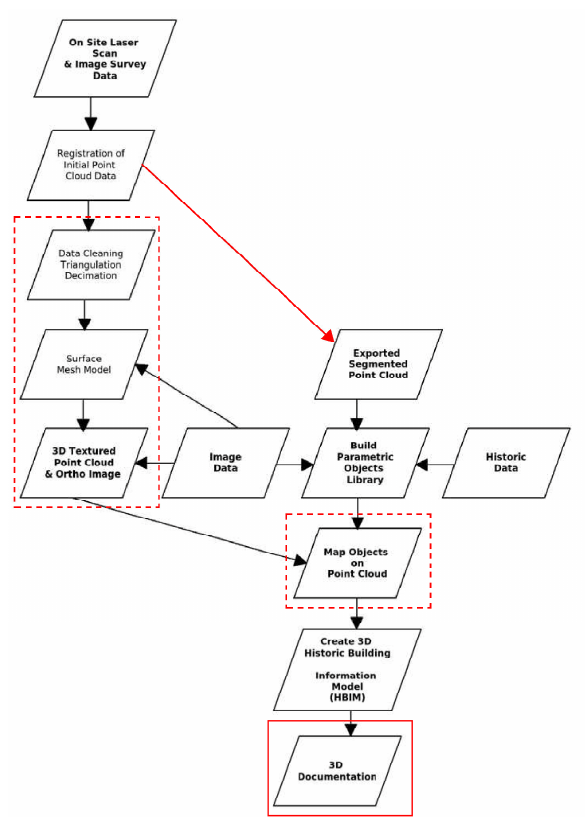
Figure 3 HBIM Workflow by Murphy (2009), marked in red by the authors: the red line with an arrow is a shortcut route, the nodes in dashed rectangles are not necessary, and the final node is supposed to be extended.